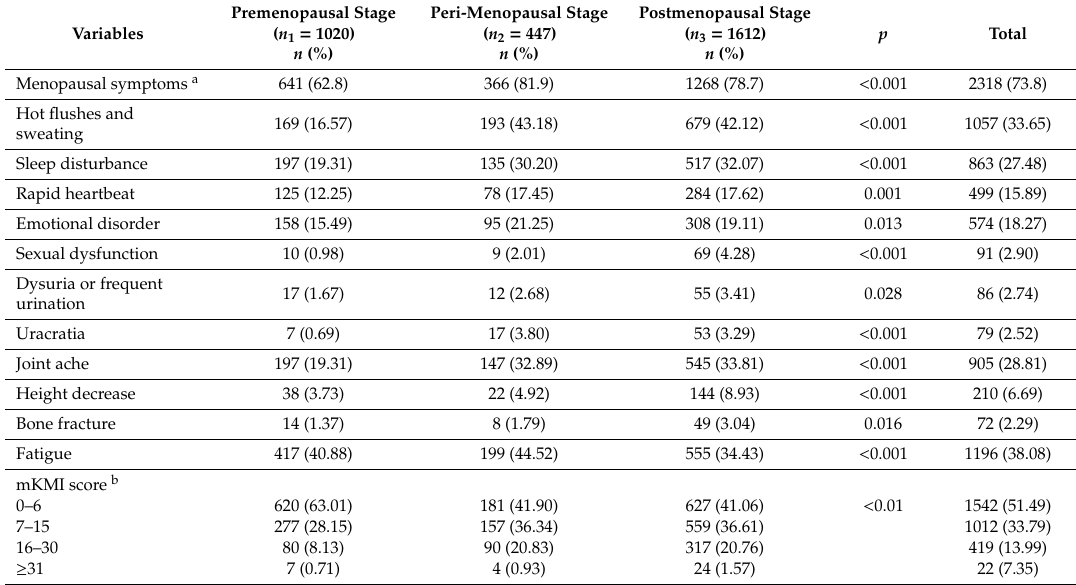
Table 2. Menopausal symptoms and the mKMI of the